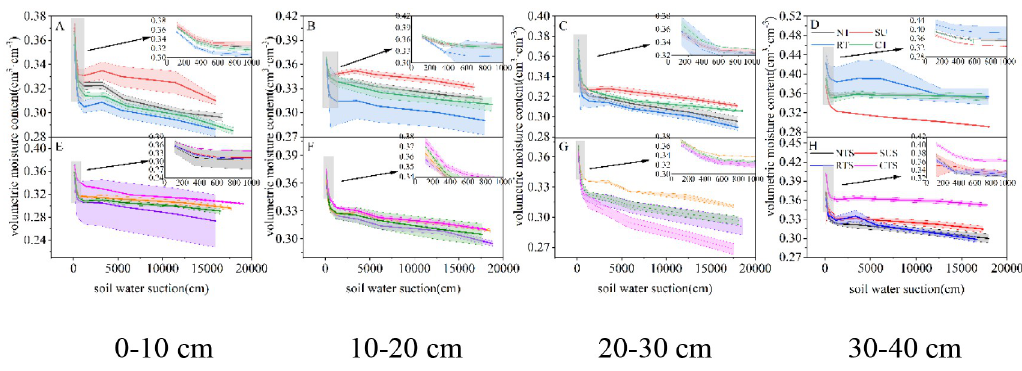
Fig 4. Change in SMCC in each soil layer with different tillage cultivations.